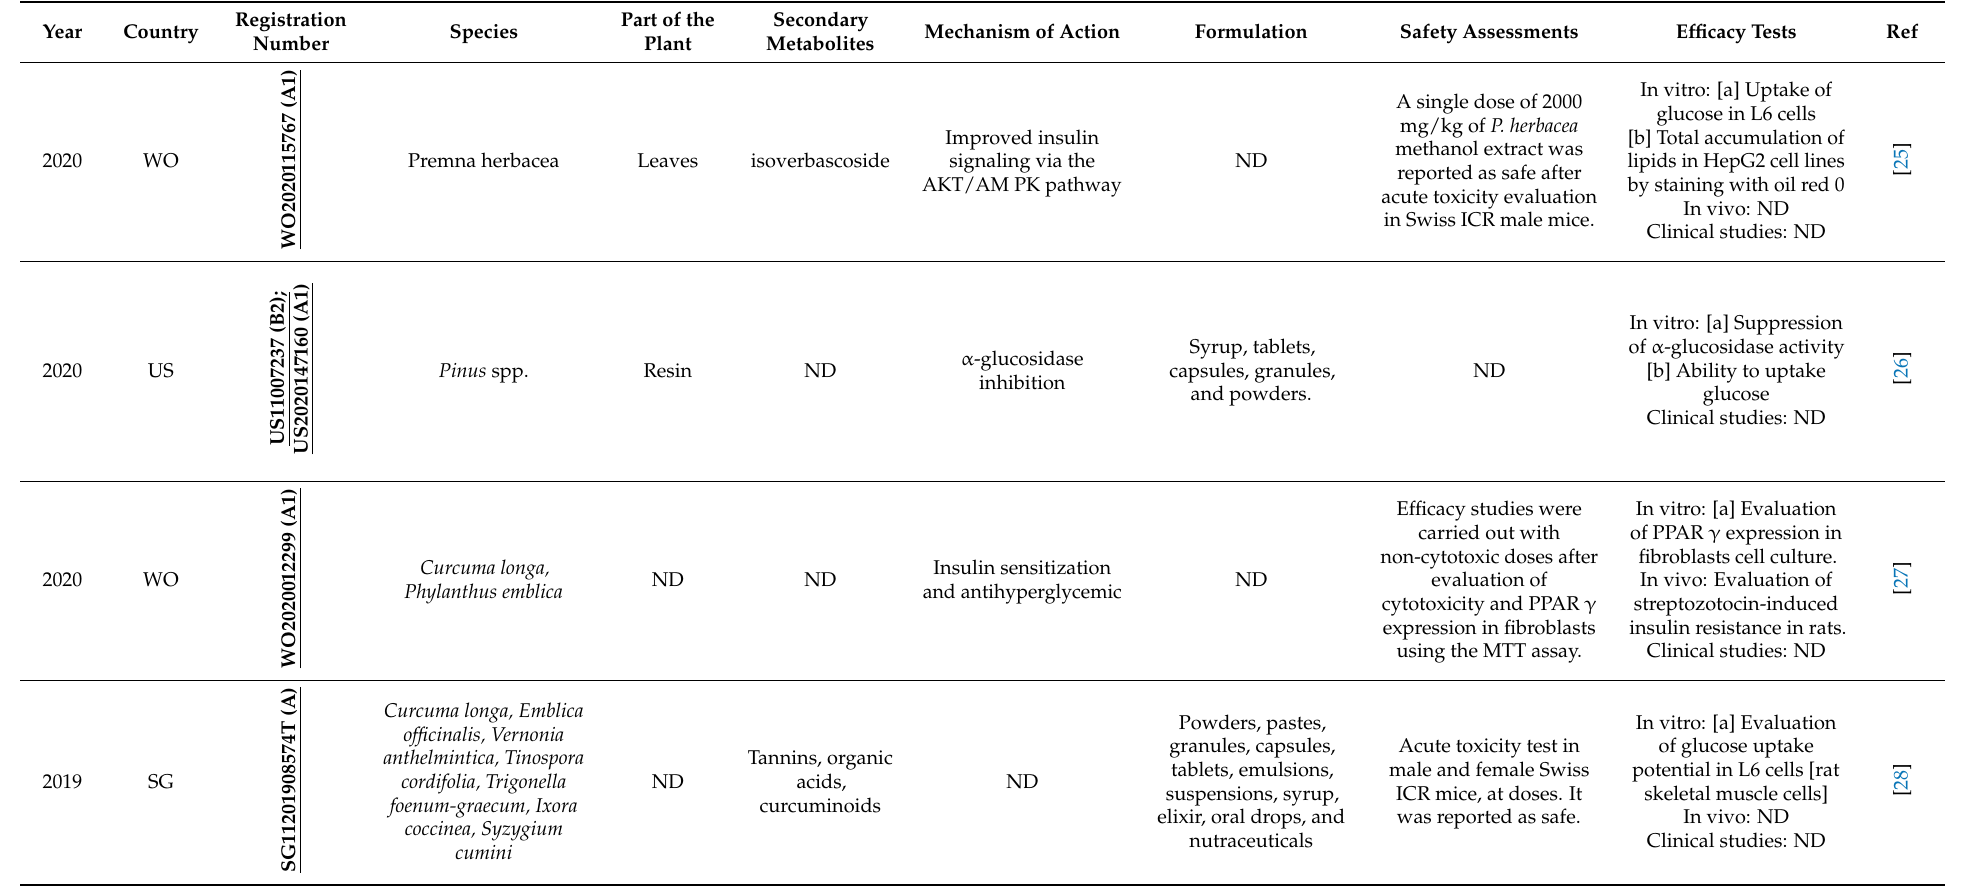
Table 1. Pharmaceutical product patents with natural origin published by EPO from 2016 to